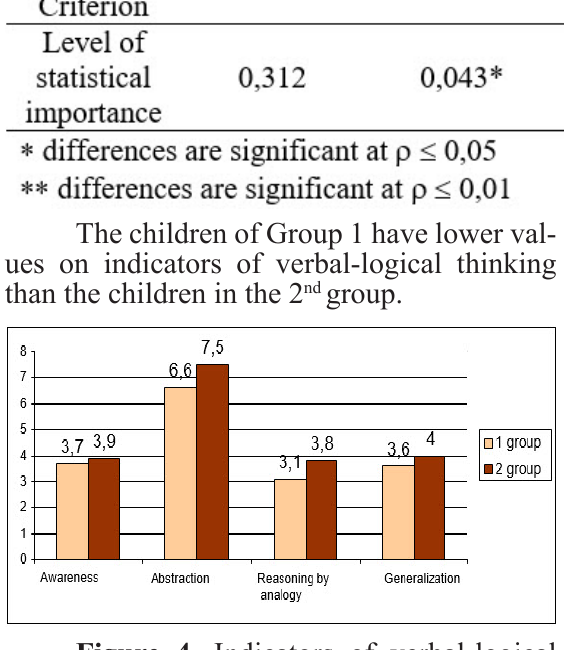
Figure 4 . Indicators of verbal-logical thinking in preschool